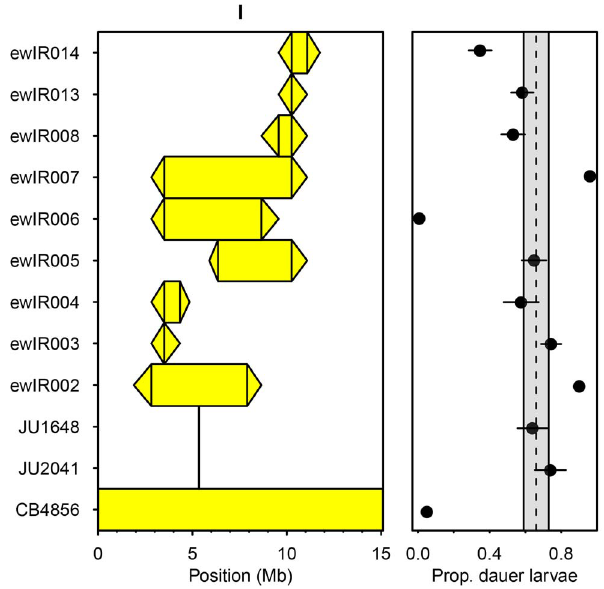
Figure 5. Variation at nath-10 does not affect dauer larvae formation in response to defined amounts of pheromone. Reanalysis of ILs with introgressions in the region of nath-10 and of JU1648 and JU2041, lines with very fine introgressions of nath- 10(haw6805) . The nath-10(haw6805) allele is the only common difference distinguishing JU2041 and JU1648 from N2, and JU2041 contains only two known alleles that differ from N2, nath-10(haw6805) and mfP19 [19]. The CB4856 introgression per IL is shown by the colored rectangle and triangles joining adjacent CB4856 and N2 markers (left hand panel), and the proportion of dauer larvae that developed in each line (right hand panel) in dauer larvae formation assays with 40 m l of dauer pheromone extract and 20 m l of 1% w/v E. coli . Error bars represent 6 1 S.E. and the dashed lines and shaded bar represent the mean 6 1 S.E. of N2.